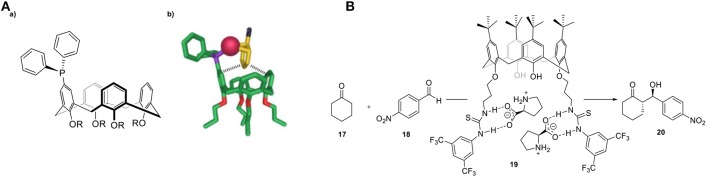
(A,a) Applied calix[4]arene ligand in coupling reactions and (b) proposed [M(0)(ArX)L] intermediate formed prior to the oxidative addition step. (B) Asymmetric aldol reaction catalyzed by an L-proline-calixarene-derived achiral thiourea host-guest complex (19).